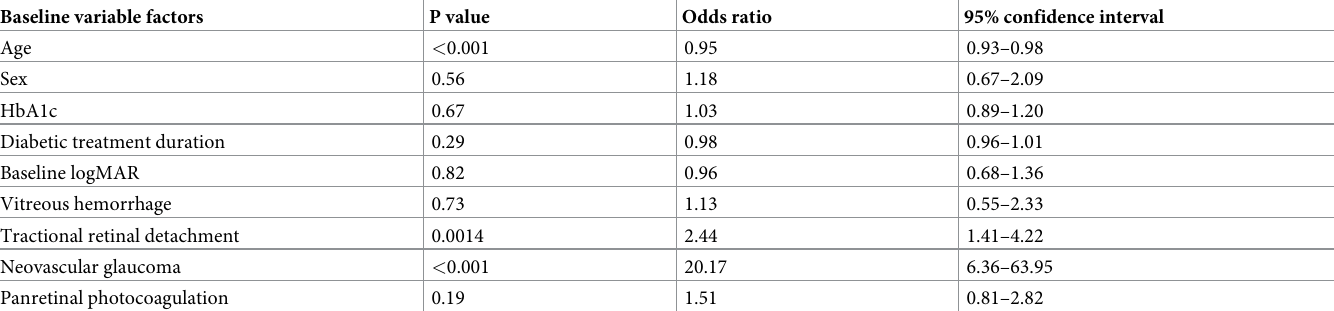
Table 5. Potential biases of preoperative intravitreal anti-VEGF